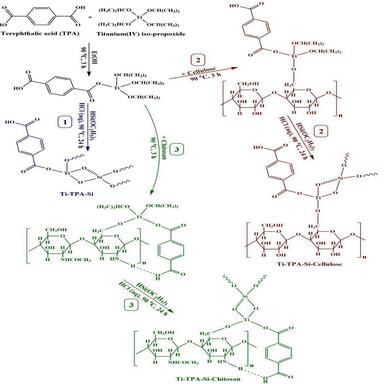
X-ray diffraction patterns of Ti-TPA-Si, Ti-TPA-Si-C, and Ti-TPA-Si-CS.